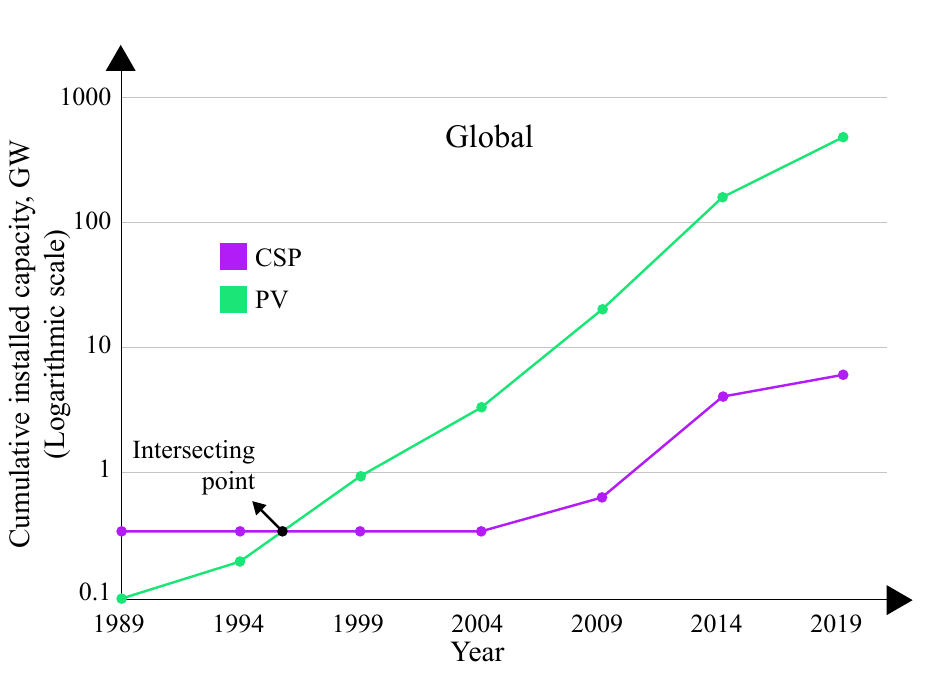
Figure 14. Timeline of global CSP and PV deployment. The logarithmic scale helps to better perceive the global perspective of how the PV caught up and surpassed CSP technology globally in the 1990s